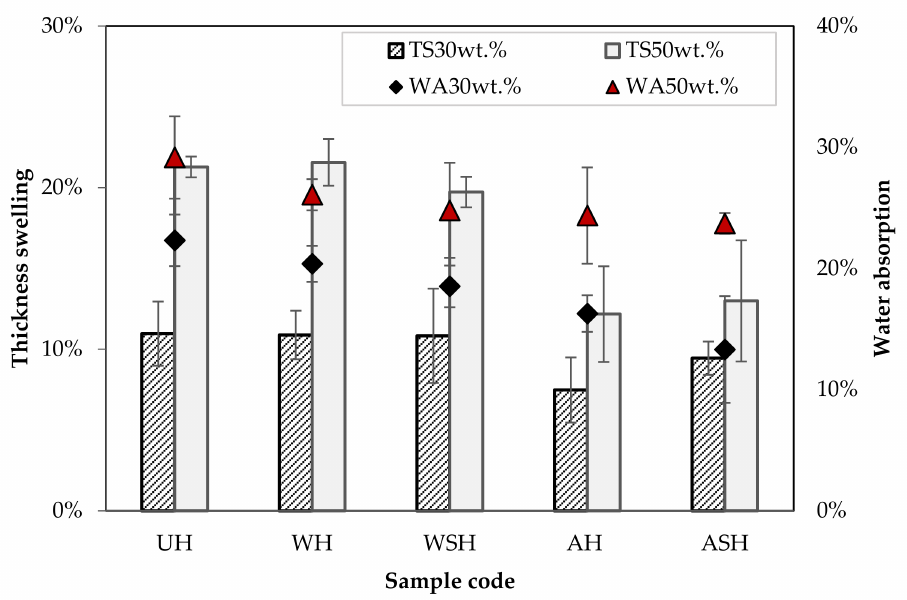
Figure 7. Water absorption and thickness swelling of the HPLA